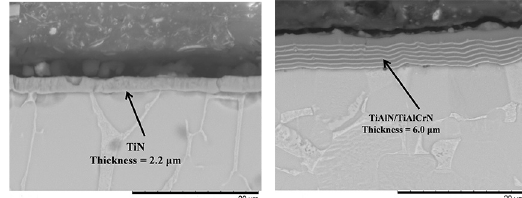
Figure 1. SEM images of PVD coated Ti-6Al-4V alloy microstructure (cross section): a) TiN and b) TiAlN/TiAlCrN. Cilindrical specimens of 8 mm diameter and 17 mm in length were hot mounted in Teflon holders. The exposed uncoated surface area (0.5 cm 2 ) was ground with SiC papers